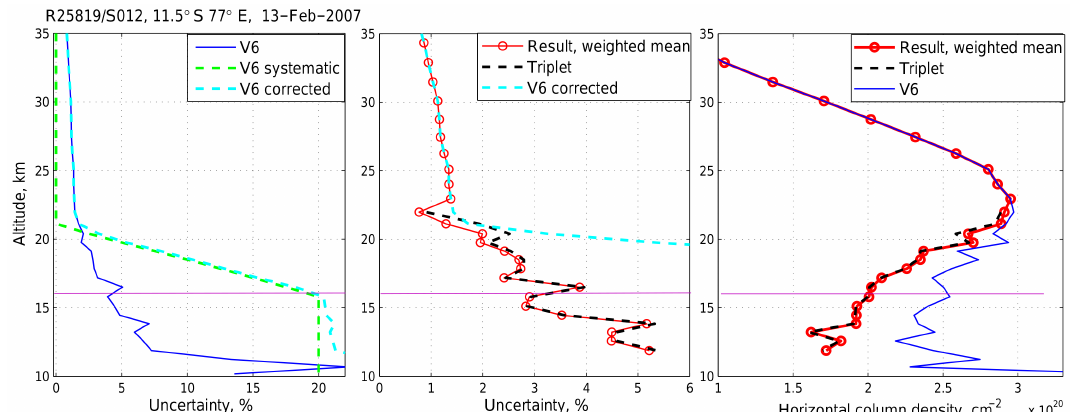
Figure 7. Illustration of combining triplet and V6 horizontal column density profiles using the data from occultation R25819/S012 (11.5 ◦ S, 77 ◦ E; 13 February 2007). Left: original uncertainty of V6 ozone HCD (blue line), systematic uncertainty (green), which is added quadrat- ically to the original V6 uncertainty, and the resulting corrected V6 uncertainty (cyan). Center: V6 corrected uncertainty (cyan, as in the left panel), the uncertainty of the triplet inversion (black), and the resulting uncertainty of the weighted mean of V6 and triplet profiles (red). Right: V6 ozone HCD (blue), ozone HCD from triplet inversion (black), and the weighted mean of V6 and triplet profiles (red). The lapse-rate tropopause height is ∼ 16km and is indicated my the magenta horizontal line.